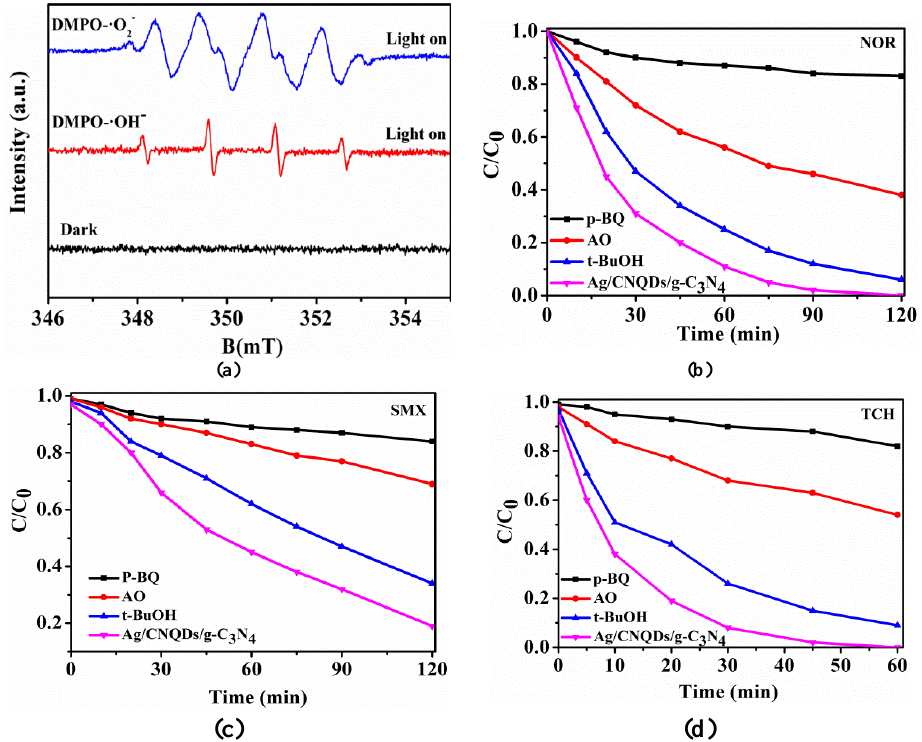
Figure 5. ( a ) ESR spectra of DMPO- • O 2– and DMPO- • OH. Effect of quenching agent on degradation of ( b ) NOR, ( c ) SMX and ( d ) TCH by Ag/CNQDs/g-C 3 N 4.